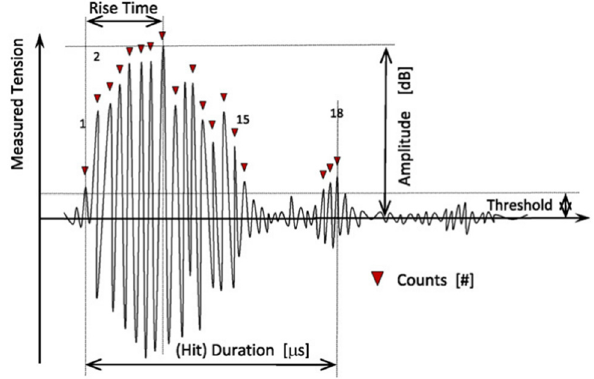
Figure 1: The characteristic parameters of a emission acoustic